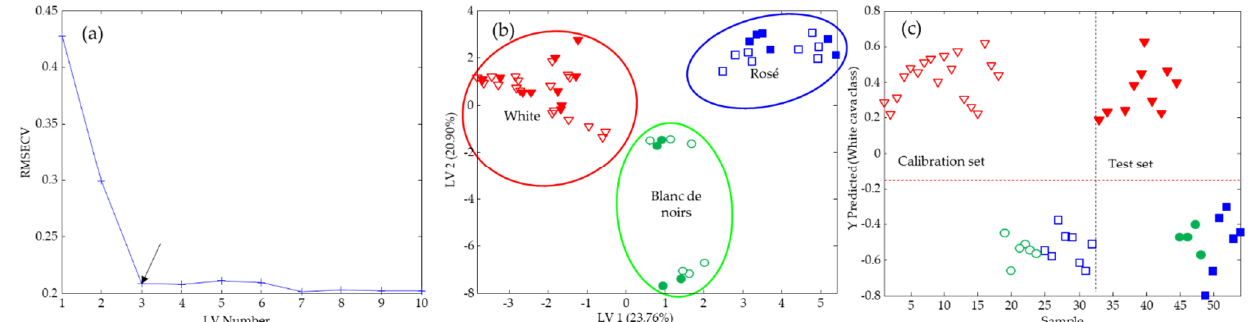
Figure 5. PLS-DA results focused on the classification of cava samples into white, rosé, and blanc de noir categories from the data fusion approach using phenolic and organic acid values as the data. ( a ) Root Mean Square Error of Cross Validation (RMSECV) for the estimation of the optimum number of LV by Venetian blinds cross validation; arrow indicates the chosen values. ( b ) Plot of scores of LV1 vs. LV2. ( c ) Classification plot for the assignation of white cava samples. Sample assignation: triangle = white; square = rosé; circle = blanc de noirs; empty symbols = calibration samples; solid symbols = validation samples. Red line indicates the classification threshold.